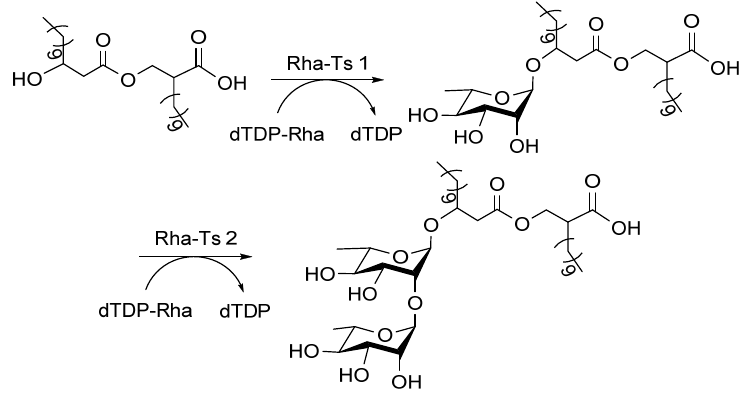
Figure 11. Rha-Ts involved in the biosynthesis of rhamnolipids